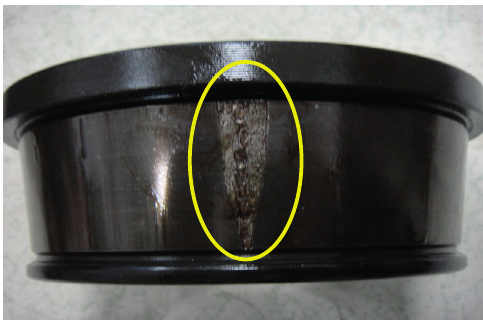
Figure 25. Inner-race of the dismantled